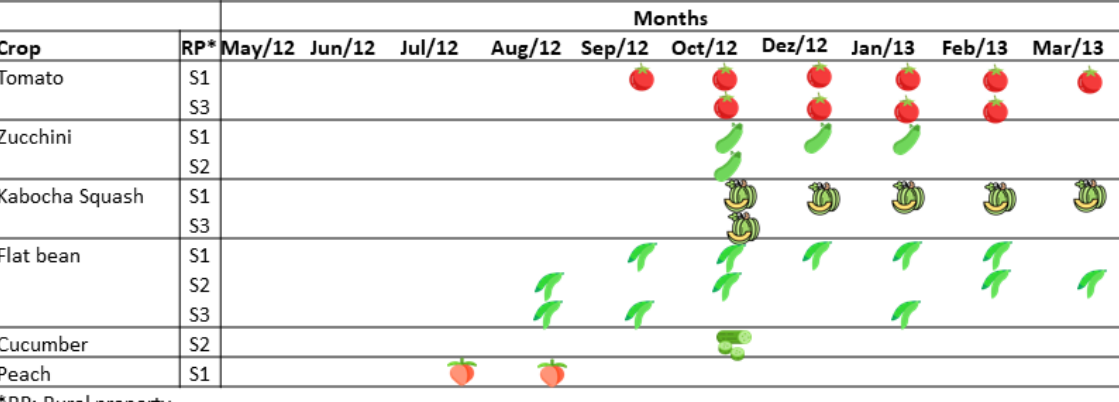
Fig 3 . Crop plants blooming period at three smallholder rural properties in Guapiara, São Paulo state, Brazil, between May 2012 and March